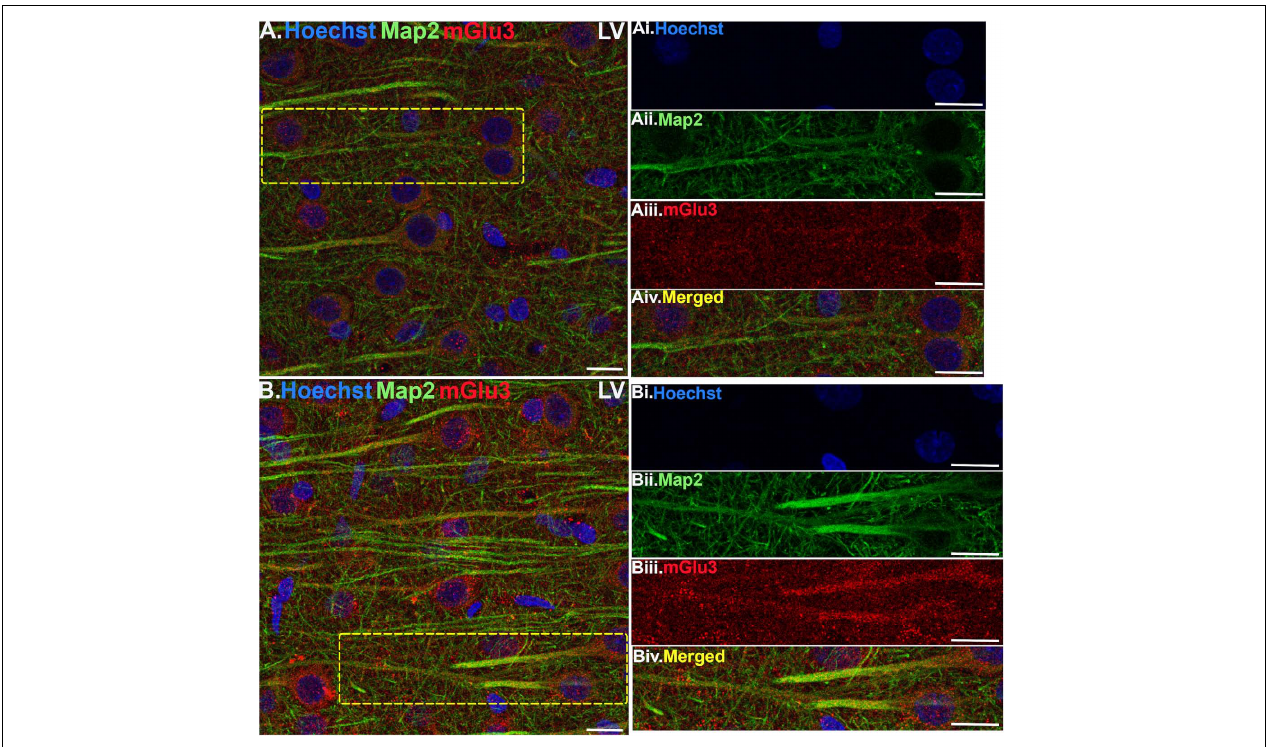
FIGURE 4 | Multiple label immunofluorescence of mGlu3 labeling in neurons in layer V of rat PL mPFC. Tissue was labeled with antibodies recognizing mGlu3 (red), the dendritic marker Map2 (green), as well as the nuclear Hoechst stain (blue). (A,B) In layer V, mGlu3 expression (red) is seen diffusely across the neuropil, with labeling within the perisomatic regions of putative pyramidal neurons as well as the apical dendrites. Two representative neurons are outlined by the yellow dashed boxes in (A,B) . (Ai–iv,Bi–iv) Correspond to the boxed areas in (A,B) . In both (Aii,iii,Bii,iii) mGlu3 labeling clearly outlines the apical dendrites, as demarcated by Map2 (green) and surrounds the nucleus (blue). Scale bars: 10 µ m.